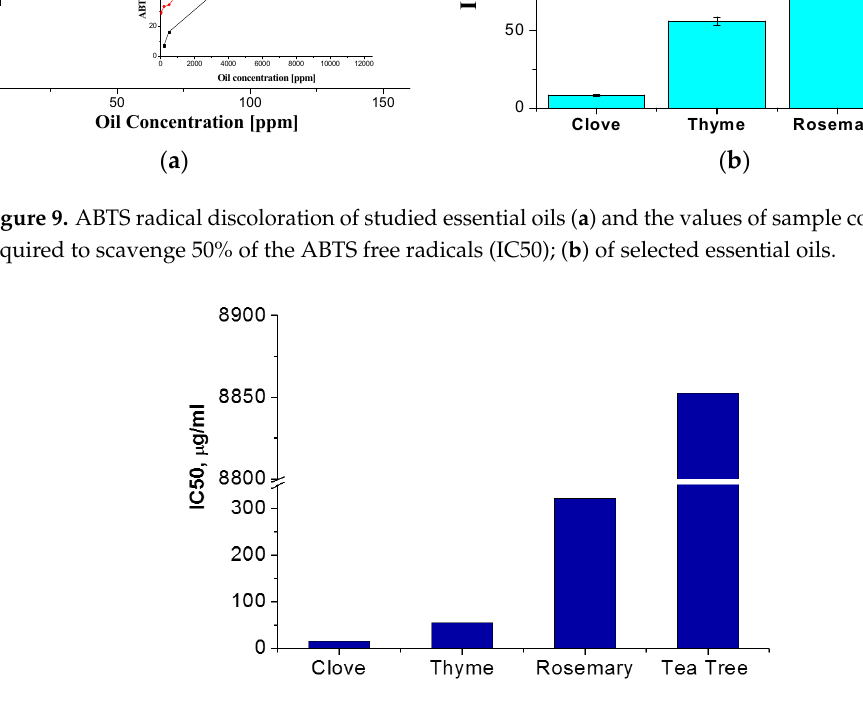
Figure 10. The values of the sample concentration required to scavenge 50% of the DPPH free radicals (IC50) of selected essential oils.